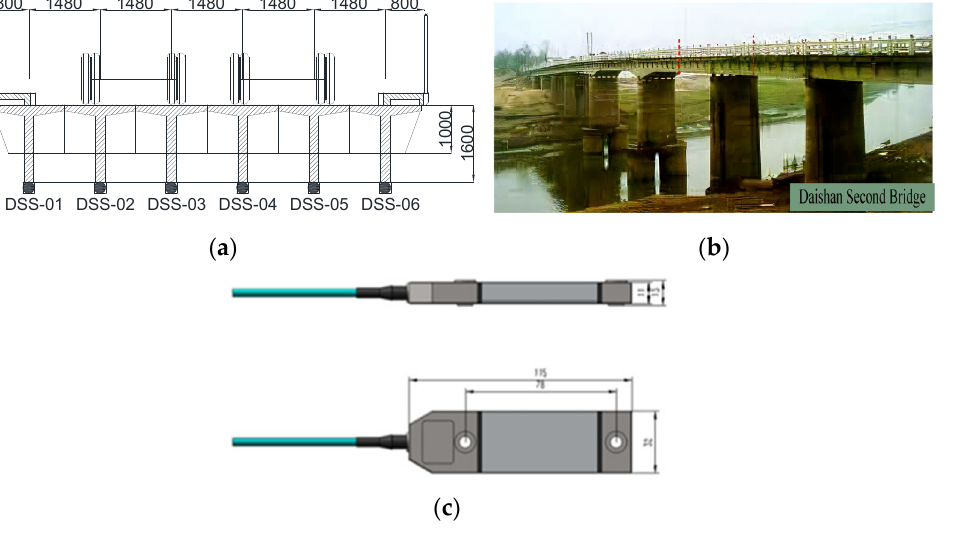
are arranged at the bottom of each T-beam in the side span, which is about 50 cm from the bottom of the beam to protect the cables (Figure 12). The sampling frequency is 20 Hz and